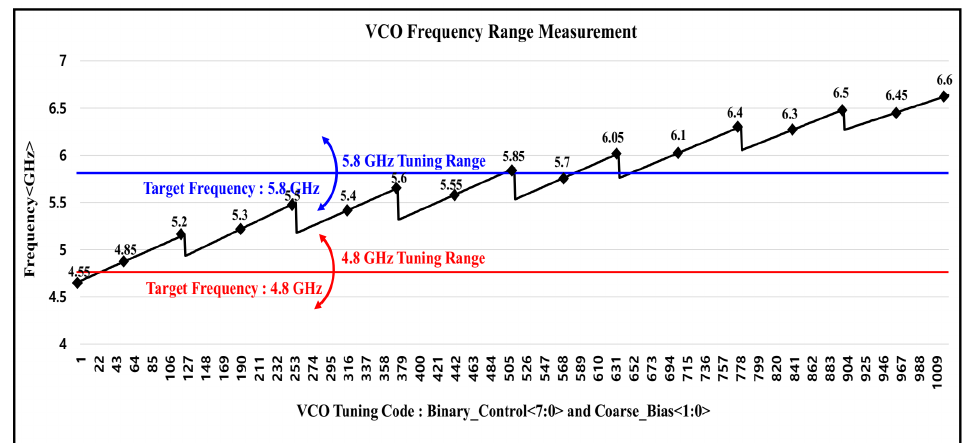
Figure 9. Frequency range of the